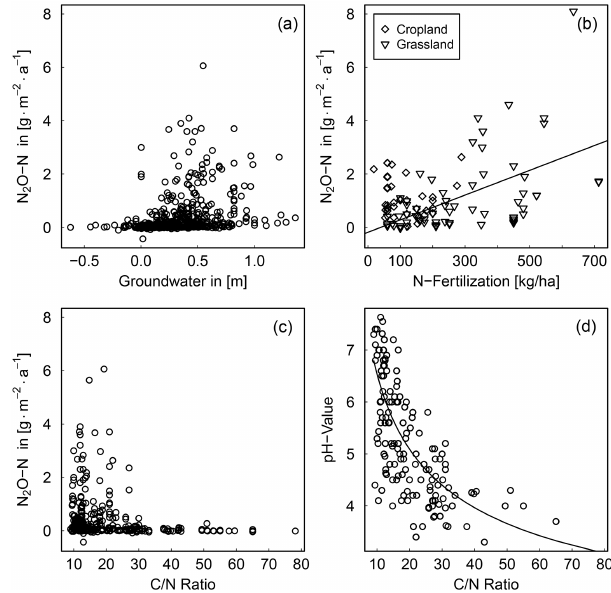
mean annual groundwater table, (b) the relationship between N fer- tilization and N 2 O fluxes for crop- and grassland with significant ( P < 0 . 001) linear relationship for grassland ( r 2 = 0 . 26), (c) the N 2 O fluxes plotted against the C/N ratios, and (d) pH values in re- lation to these C/N ratios including the fitted non-linear function (ph = 15cn − 0 . 36 ) ( r 2 =